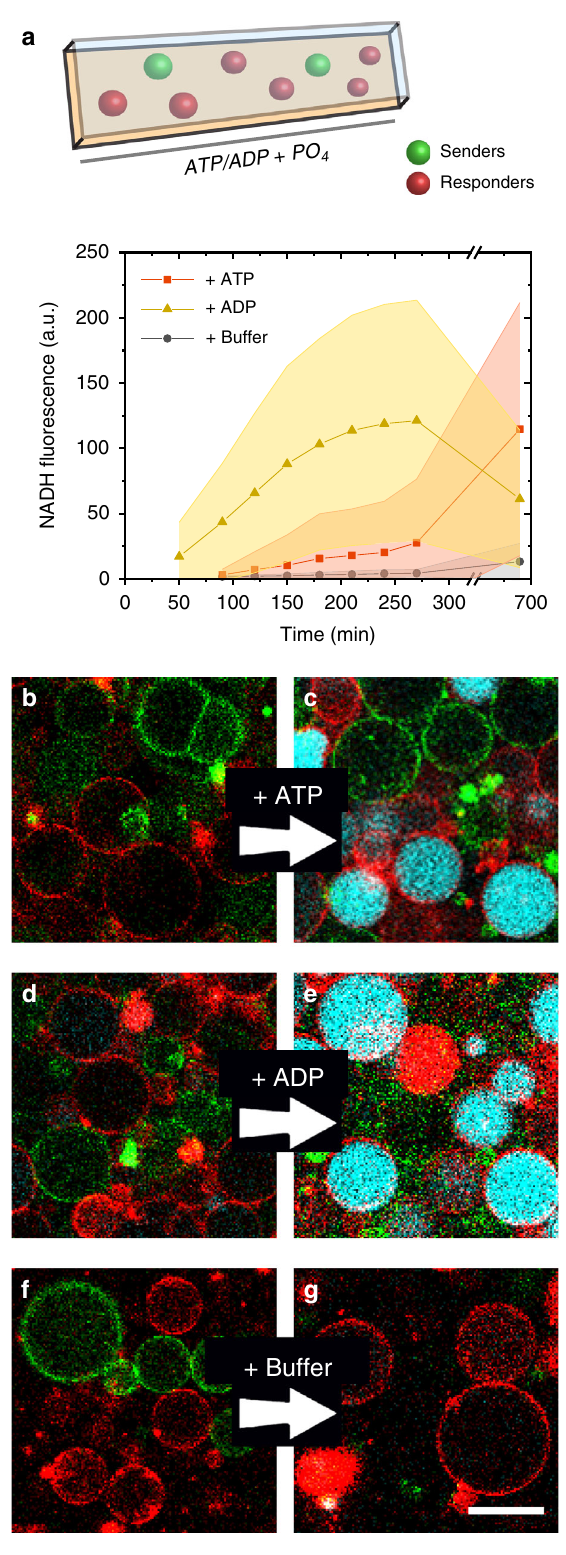
Fig. 4 AMP-mediated signalling from Senders to Receivers. a Senders and Receivers were mixed and incubated with ATP, ADP or buffer, as well as Na 2 HPO 4 . Both ATP and ADP (2.6 mM) were converted by Senders into AMP, which in turn activated the Receivers. As ATP was converted into AMP via ADP, the delay for activation of the Receivers was longer than when ADP was added directly. When ADP and ATP were both omitted, the Senders did not activate the Receivers. The decrease in NADH fl uorescence after the initial activation was caused by gradual ef fl ux of NADH through the α HL pores. Error bars depict the SD from 25 Receivers. b – g CLSM micrographs corresponding to the graph in ( a ). Receiver GUVs were labelled with DOPE-(Lissamine Rhodamine B) and Sender GUVs with DOPE-carboxy fl uorescein. Overlay of NADH fl uorescence (cyan), Sender GUVs (green) and Receiver GUVs (red). b , d , f t = 50 min after ATP/ADP/ buffer addition; c t = 690 min; e , g t = 270min. Scale bar represents 30 µ